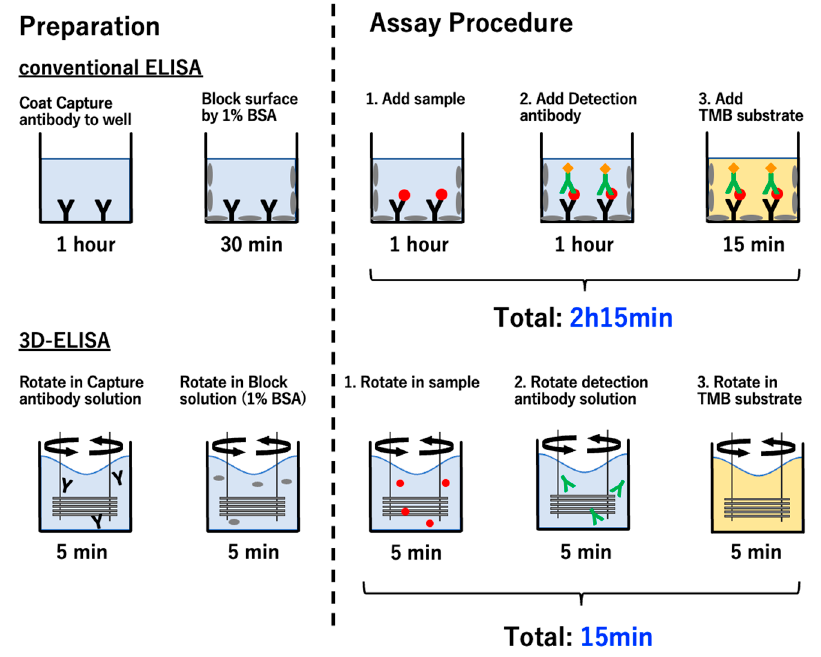
Figure 4. Scheme of sandwich ELISA using a conventional 96-well plate and 3D-Stack methods. Black Y is goat anti-human IgA antibody; Green Y with orrange dots is detection antibody with HRP; gray dots are BSA for blocking; red dot are human IgA, Orange squares in last step are AMB substrate.